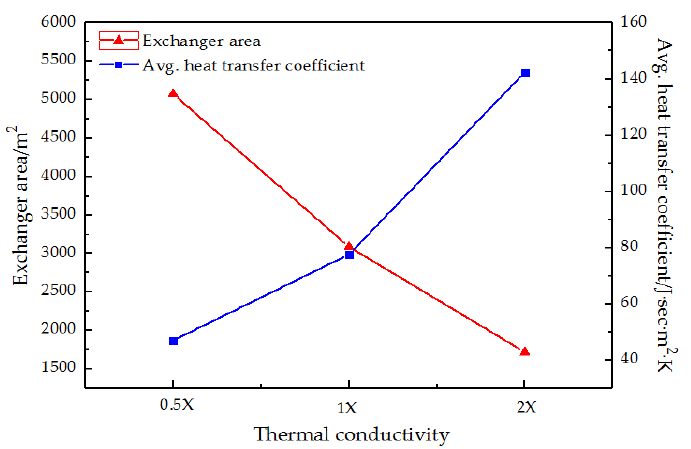
Figure 8. Effect of thermal conductivity of [emim][Tf 2 N] on the heat exchanger area and the average heat transfer coefficient of the heat exchanger. The red represents the exchanger area and the blue represents the average heat transfer coefficient.